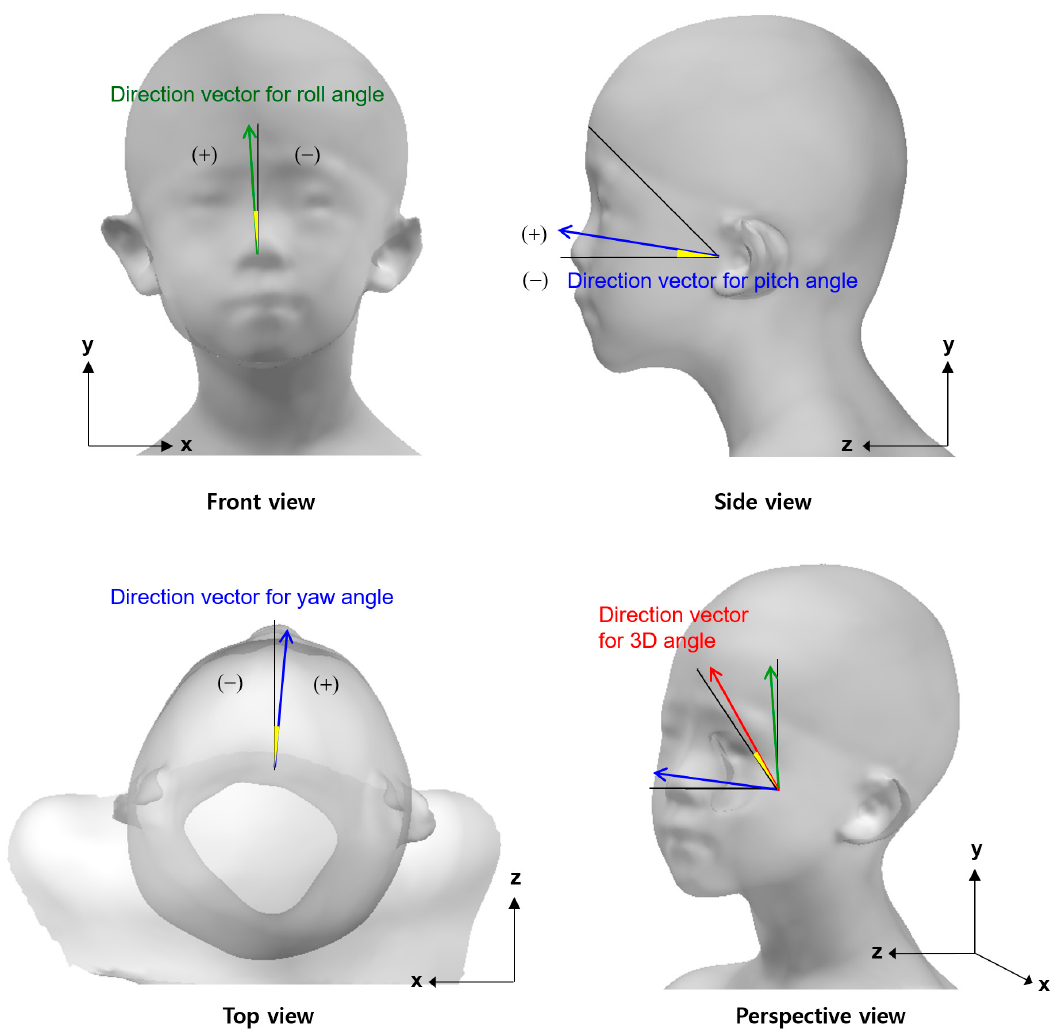
Figure 6. Direction vectors for measurement of head deviation compared to reference vectors.